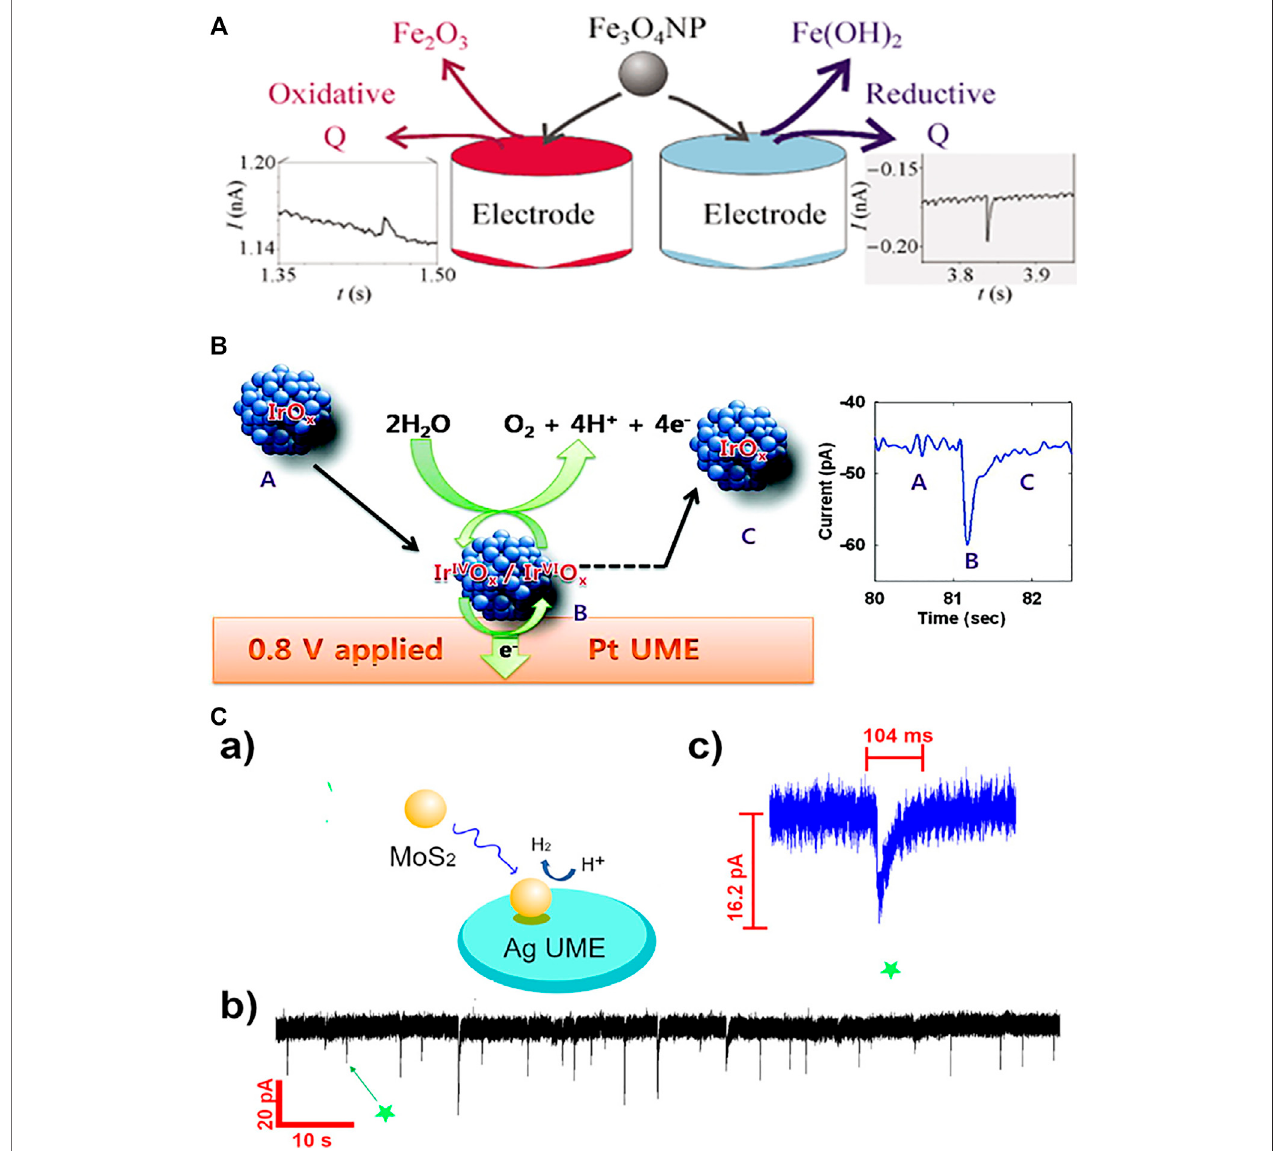
FIGURE 1 | (A) The nano-impact measurements of single Fe 3 O 4 magnetite nanoparticles using both anodic particle coulometry (APC) and cathodic particle coulometry (CPC) to independently get the size information of Fe 3 O 4 nanoparticles (Tschulik et al., 2013). Copyright © 2013 Springer (B) Schematic illustration of